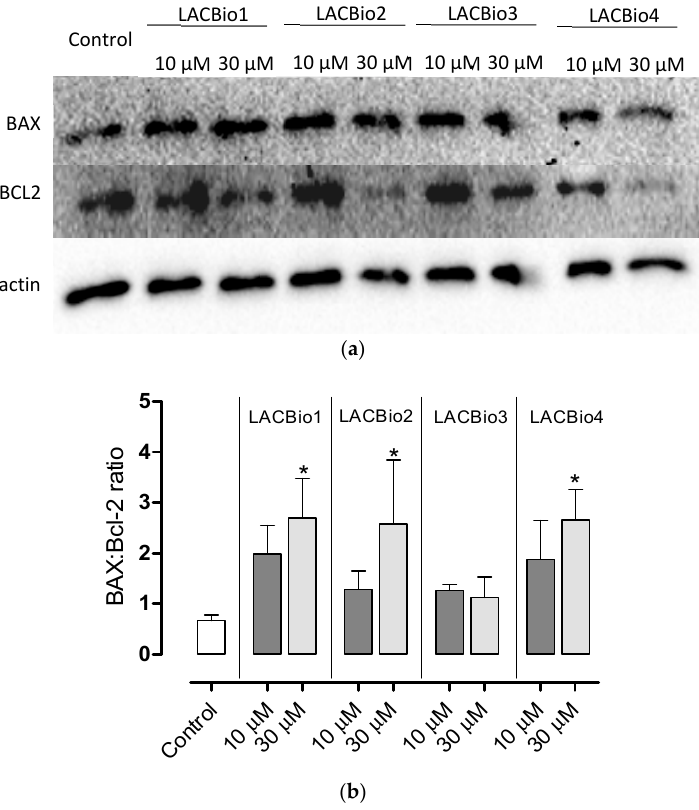
Figure 4. LACBio1, LACBio2 and LACBio4 caused an increase in the Bax:Bcl-2 ratio. In ( a ), representative Western blotting shows the expression levels of Bax, Bcl-2 and β -actin. In ( b ), densitometric analysis was used to determine the Bax:Bcl-2 ratio. All the values are represented as the mean ± standard error of three independent experiments. Statistical analyses were performed with GraphPad Prism 8.02 and included one-way ANOVA followed by Dunnett´s post hoc test. Statistical significance was defined as * p < 0.05 when compared with the control group.